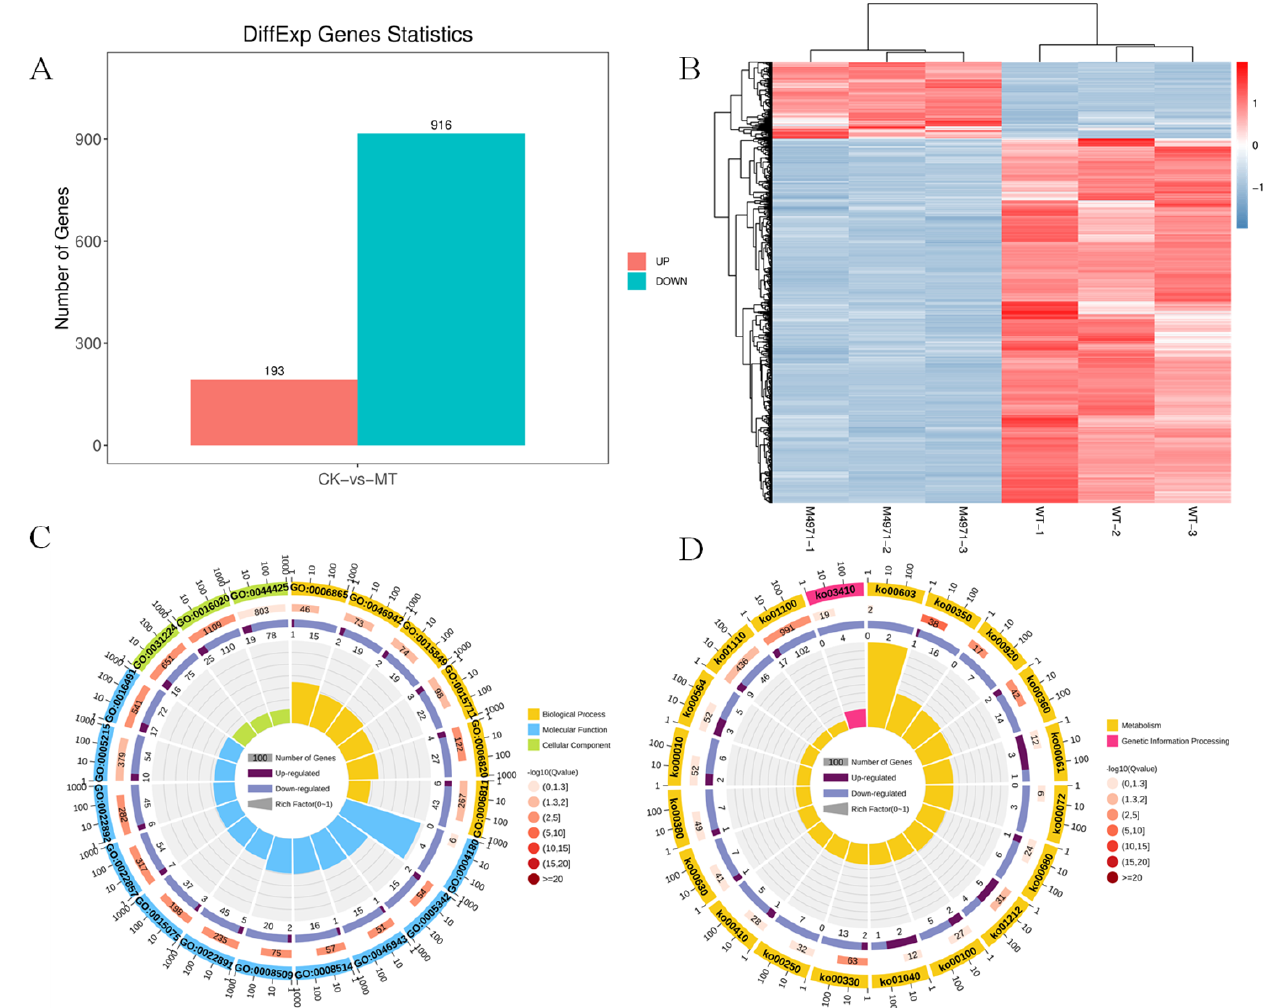
Figure 10. Comparison of gene expression data between the mutant strain M. purpureus ∆ 4971 (MT) and the wild-type strain M. purpureus LQ-6 (WT). Number of DEGs in MT compared to WT ( A ), the DEGs clustering ( B ), GO enrichment analysis ( C ) and KEGG enrichment analysis ( D ).